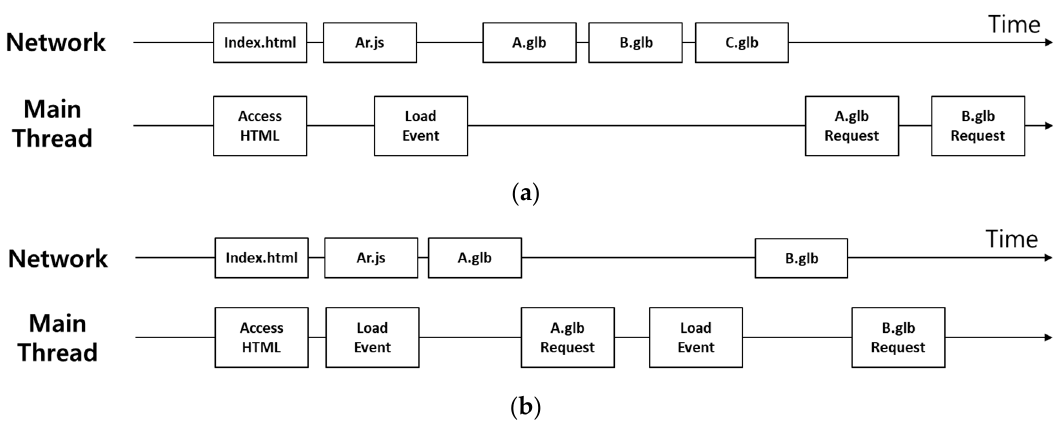
Figure 3. Resource loading sequence: ( a ) conventional method; ( b ) proposed method.